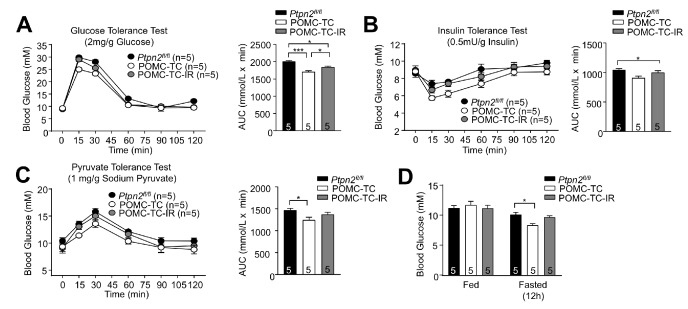
TCPTP regulation of insulin signaling alters the POMC neuronal control of glucose metabolism.(a) Glucose (2 mg/g), (b) insulin (0.5 mU/g), and (c) pyruvate (1 mg/g) tolerance tests in 8–12 week-old male Ptpn2fl/fl, POMC-TC or POMC-TC-IR mice; areas under curves were determined and significance was determined using a one-way ANOVA followed by Tukey multiple comparison test. (d) Fed and fasted blood glucose levels in 10–12 week-old male Ptpn2fl/fl, POMC-TC or POMC-TC-IR mice; significance determined using a two-way ANOVA followed by Sidak multiple comparison test. Quantified (means ±SEM) results are shown for the indicated number of mice.